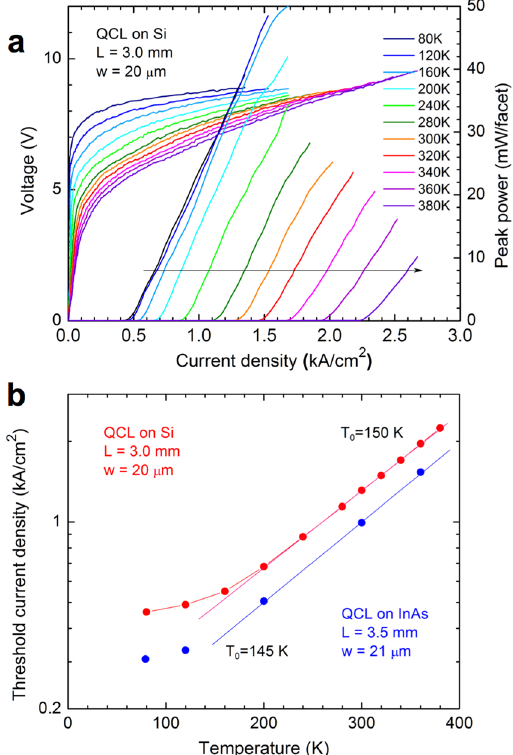
Figure 4. Characteristics of the studied QCLs at different temperatures. ( a ) Voltage-current and light-current characteristics of a QCL grown on Si measured between 80 and 380 K. ( b ) Threshold current density as a function of temperature of QCLs grown on Si and on InAs.